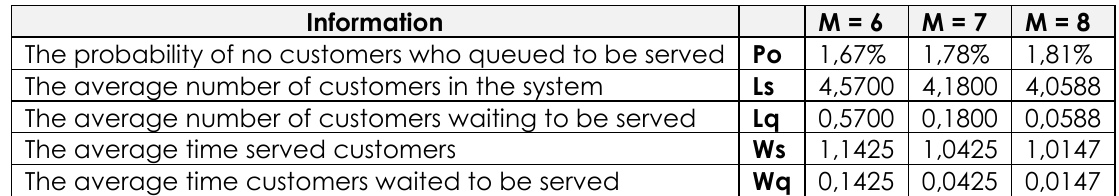
Table 4. Results Calculation of Queue Systems Model with The Addition of Service Facilities